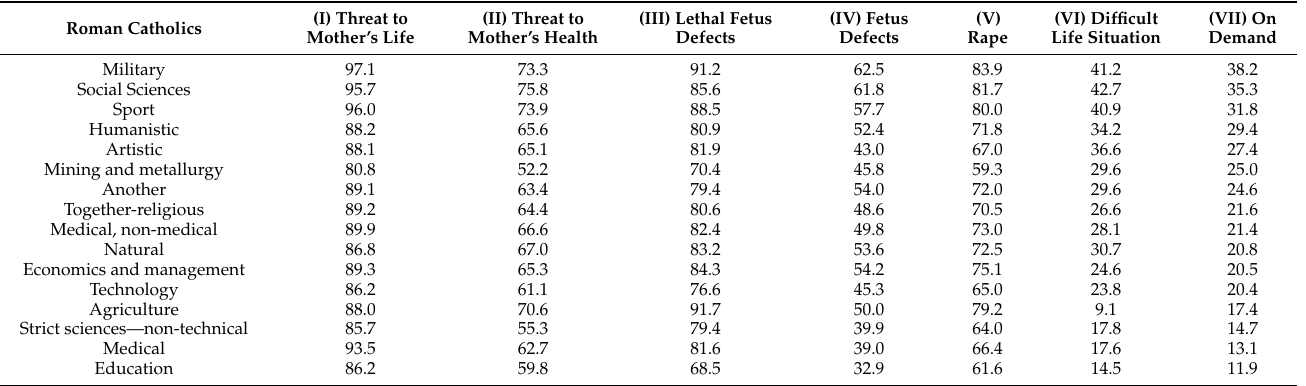
Table 7. Attitude to abortion among Roman Catholics students regarding field of study. All data contained in table are presented as percentage [%] of answers YES for question “Do you think abortion should be legal in the following cases?” in each